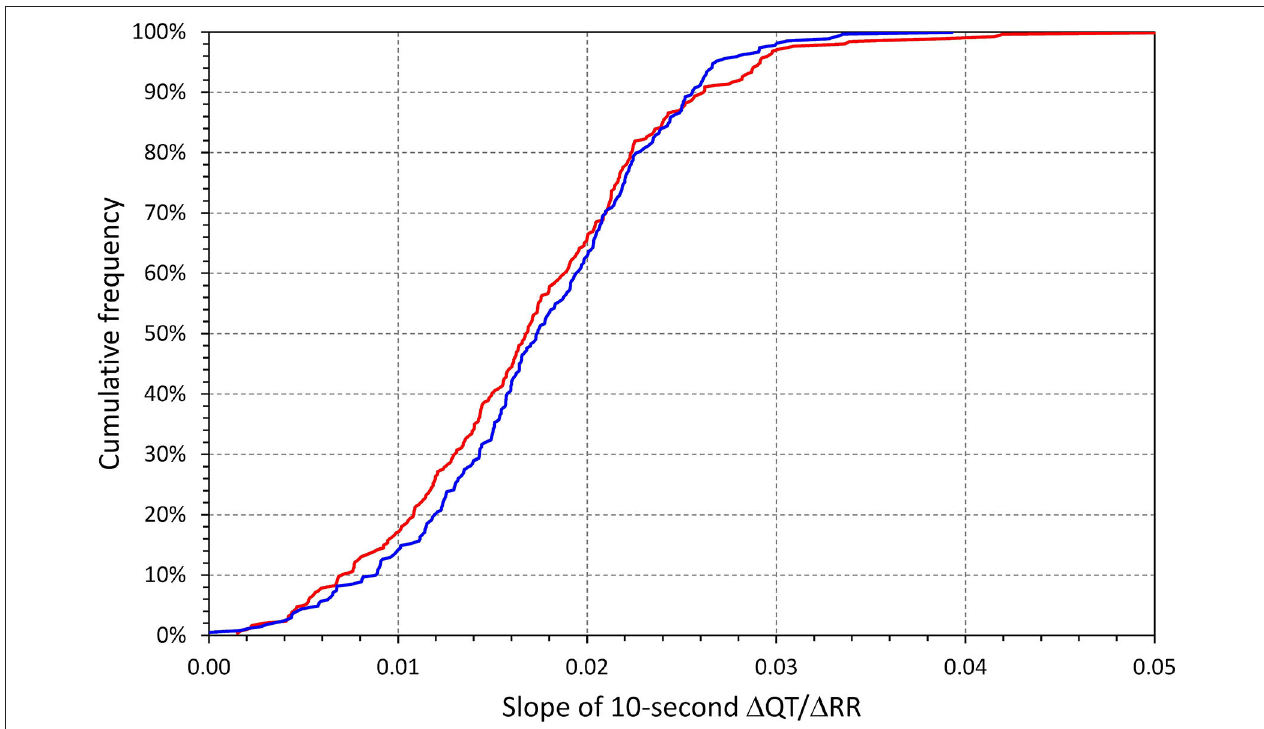
FIGURE 3 | Cumulative distributions of intra-subject linear 1 QT/ 1 RR regression slopes. In each subject, the regression involved all individual beats accepted for the given subject. The red and blue lines correspond to females and males,